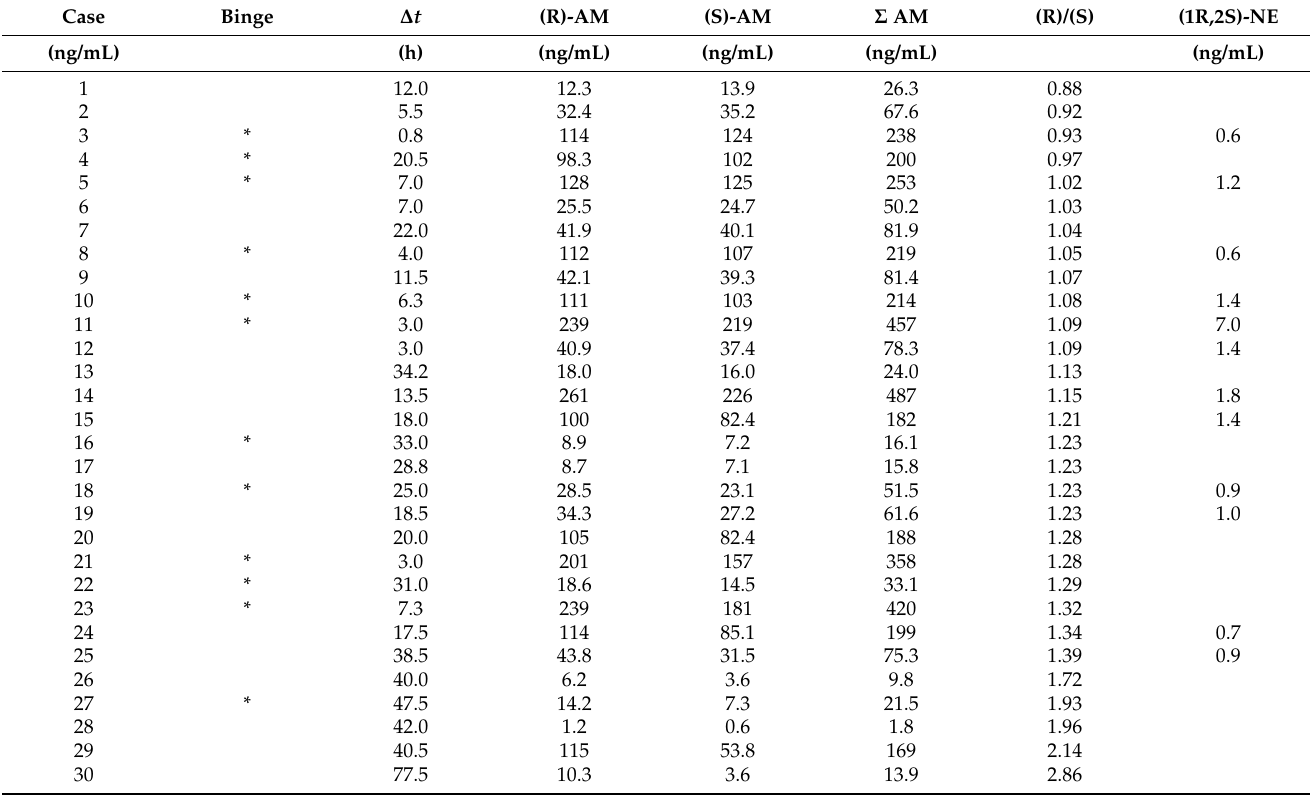
Table 2. Summary of cases with self-reported consumption